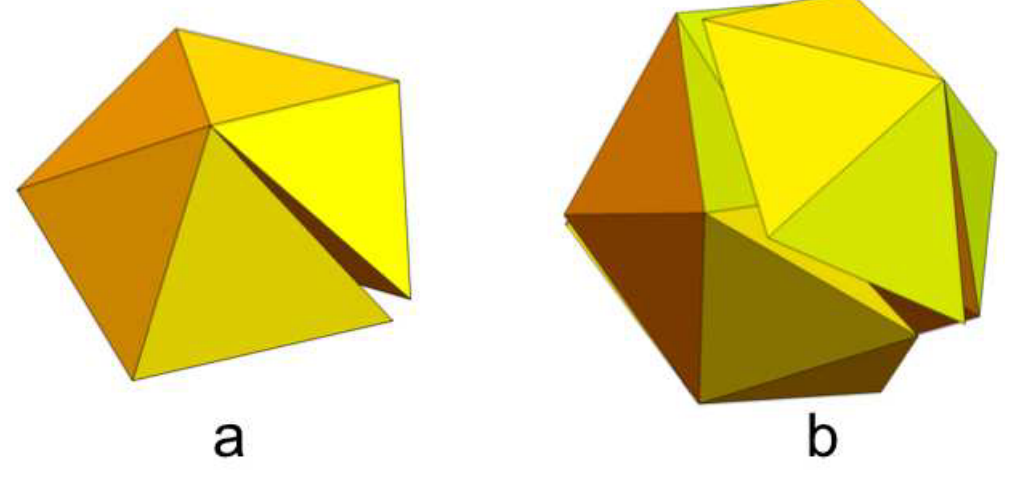
Figure 1. Images of: ( a ) edge-sharing; and ( b ) vertex sharing local tetrahedral clusters, which fail to locally fill